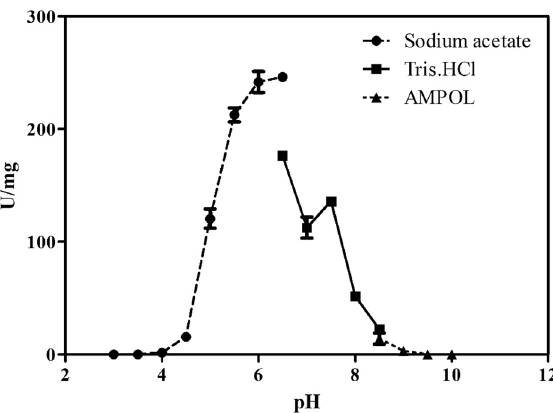
Figure 7. Relative activity at different pH values and ionic species. Values are represented as the mean ± standard